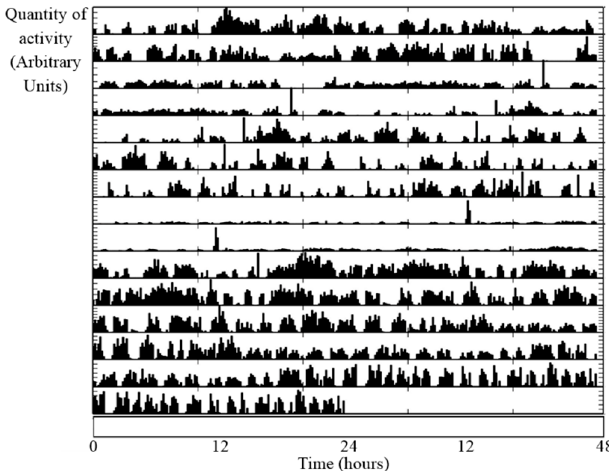
Figure 6. Example of double-plot actograms on the screen of the Raspberry-Pi.